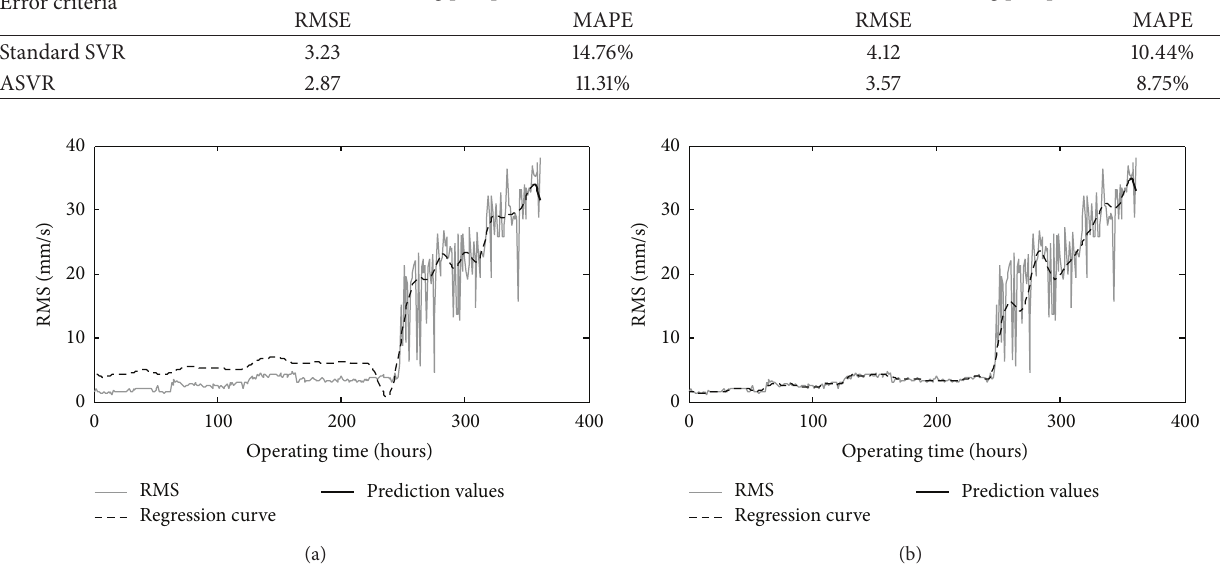
Figure 5: Prediction for the state of descaling pump number 2: (a) prediction results of standard SVR; (b) prediction results of